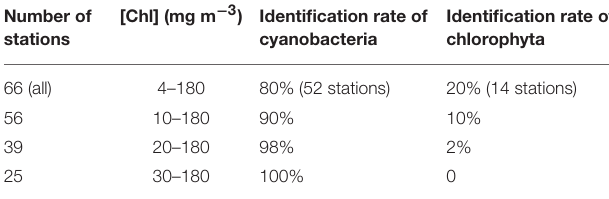
FIGURE 6 | Phytoplankton-group-classified spectra of (A) in situ R rs ( λ ) in Lake Taihu in 400–700 nm, (B) the corresponding area-normalized R rs ( λ ), and (C) second derivative spectra in 420–620 nm. TABLE 3 | Phytoplankton groups identification in Lake Taihu with different [Chl]